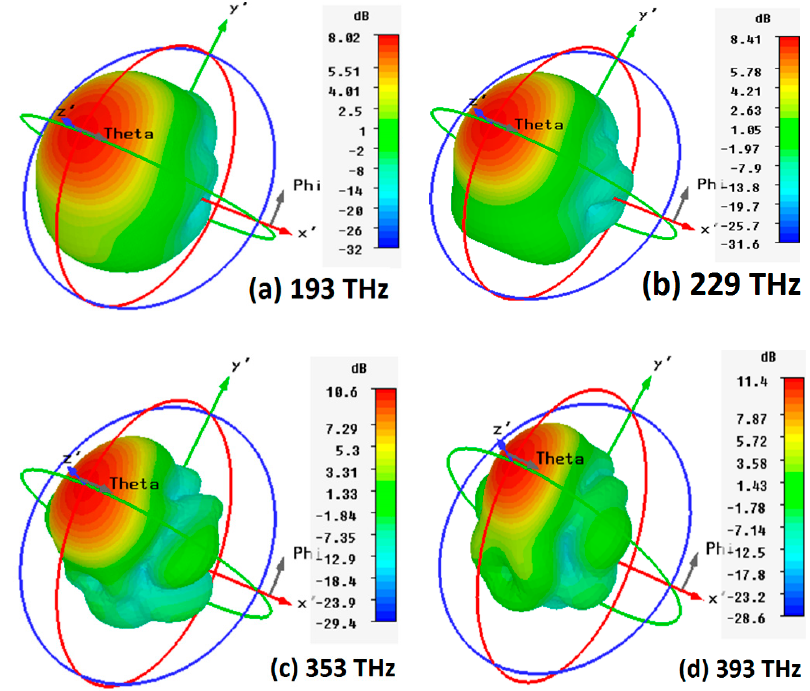
Figure 9. Three-dimensional far-field gain pattern for the designed antenna at ( a ) 193 THz ( b ) 229 THz ( c ) 353 THz and ( d ) 393 THz ( c ) 353 THz and ( d ) 393